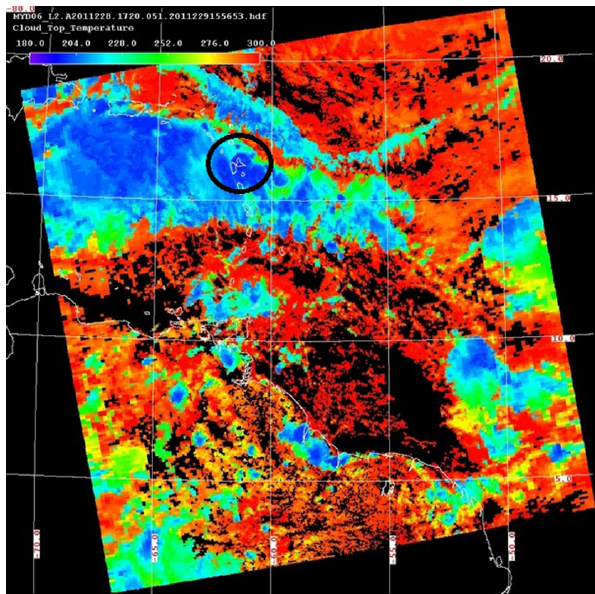
Figure A4. Cloud top temperature observed by the MODIS instru- ment. In the area of interest (black circle 61.64 ◦ W 16.19 ◦ N) the cloud top temperature drops to ≈